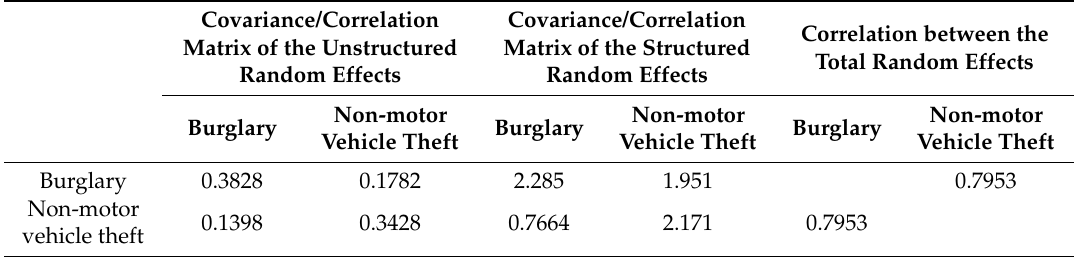
Table 4. Posterior covariance/correlation matrix of the random effects: upper triangle, covariance of the random effects; lower triangle, correlation of the random